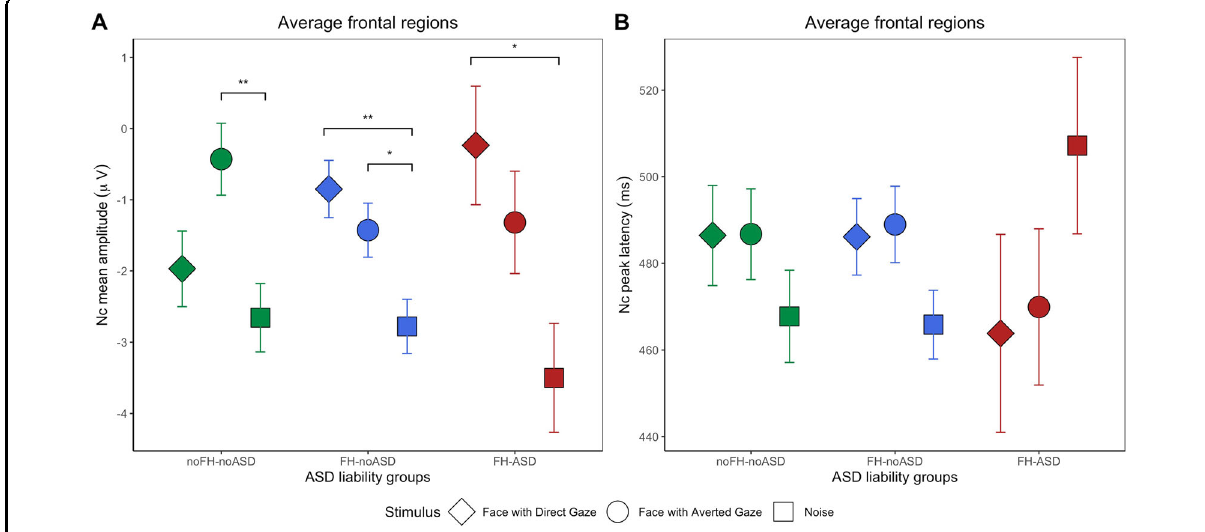
Fig. 3 Mean Nc features by group and stimulus. Mean amplitude ( A ) and peak latency B of the Nc by stimulus and ASD liability group, averaged across the frontal regions. All error bars represent ± 1 standard error.